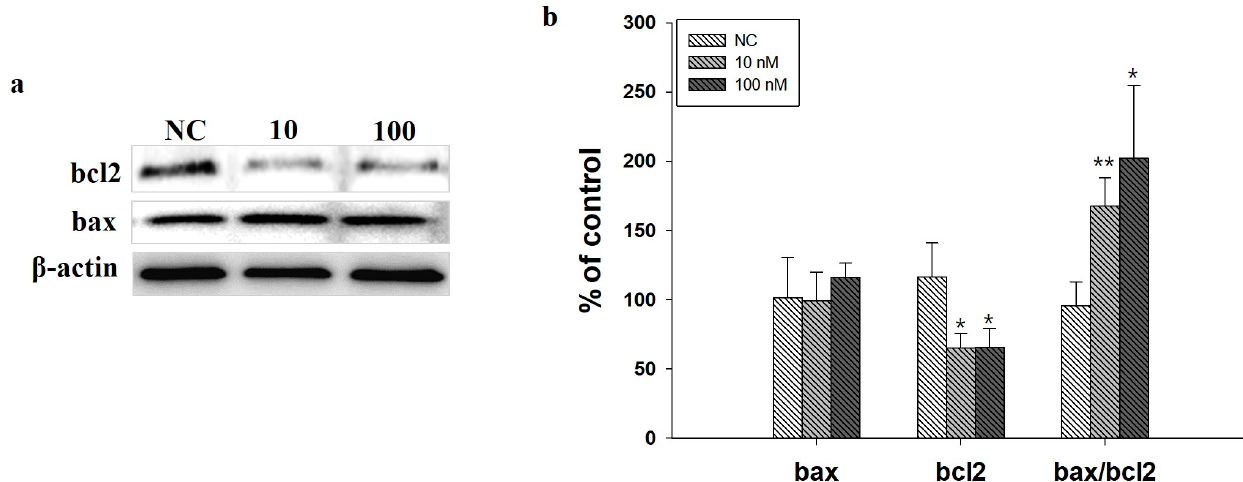
Figure 6. (a) Western immunoblot analysis revealed that the administration of ITGA7 siRNA significantly decreased bcl2 expression and increased the bax/bcl2 ratio in SH-SY5Y cells. ( b ) NC, negative control siRNA treatment (100 nM for 24 h); 10, ITGA7 siRNA treatment (10 nM for 24 h); 100, ITGA7 siRNA treatment (100 nM for 24 h). * denotes p < 0.05 and ** p < 0.001 compared to NC. All values are expressed as mean ± standard error, and statistical analysis was performed using ANOVA.